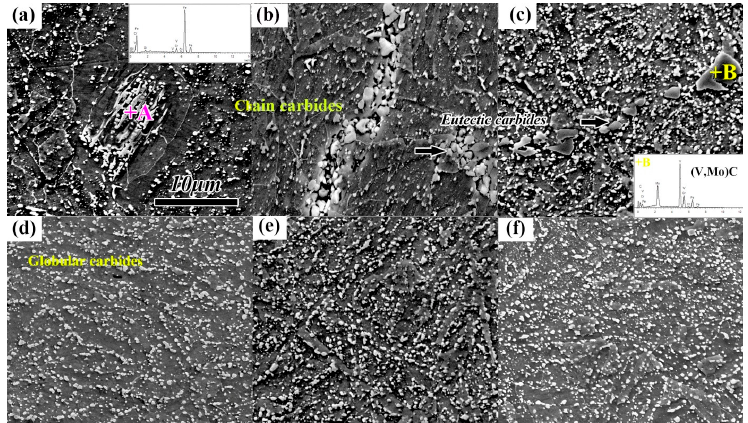
Figure 4. SEM and EDS observations of the annealed specimens: ( a ) Carbides aggregation in 0RE; ( b ) chain carbides in 0RE; ( c ) the eutectic carbides in 0RE; ( d ) ellipsoid carbides in 0.018RE; ( e ) ellipsoid carbides in 0.048RE and ( f ) ellipsoid carbides in 0.15RE. (The insert in ( a ) is the EDS analysis of